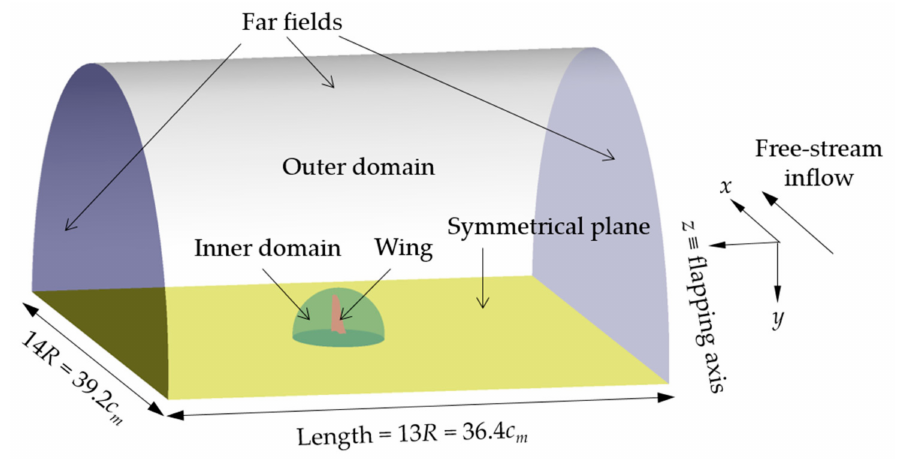
Figure 7. Computational domain.